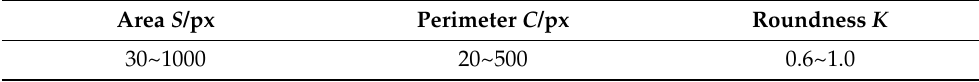
Table 6. The parameter ranges of geometric